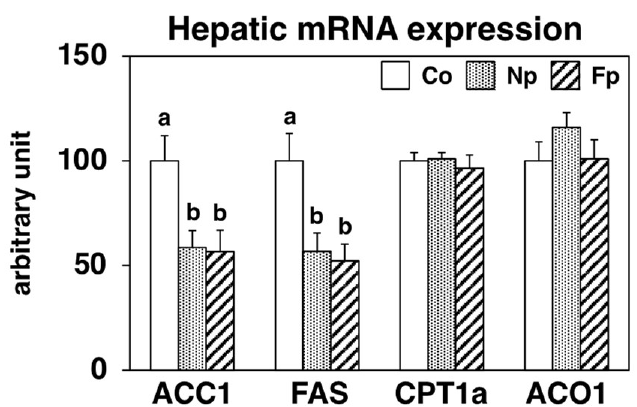
Figure 4. mRNA expression levels of genes related to lipid metabolism in the liver of db / db mice fed a basal diet (Co group), 10% NP-supplemented diet (Np group), or 10% FNP-supplemented diet (Fp group) for 4 weeks. Values are expressed as the mean ± standard error (n = 5–6). ab Different letters denote significant differences ( p < 0.05) among the three groups. ACC1: acetyl-CoA carboxylase-1, FAS: fatty acid synthase, CPT1a: carnitine palmitoyltransferase-1a, ACO1: acyl-CoA oxidase-1.